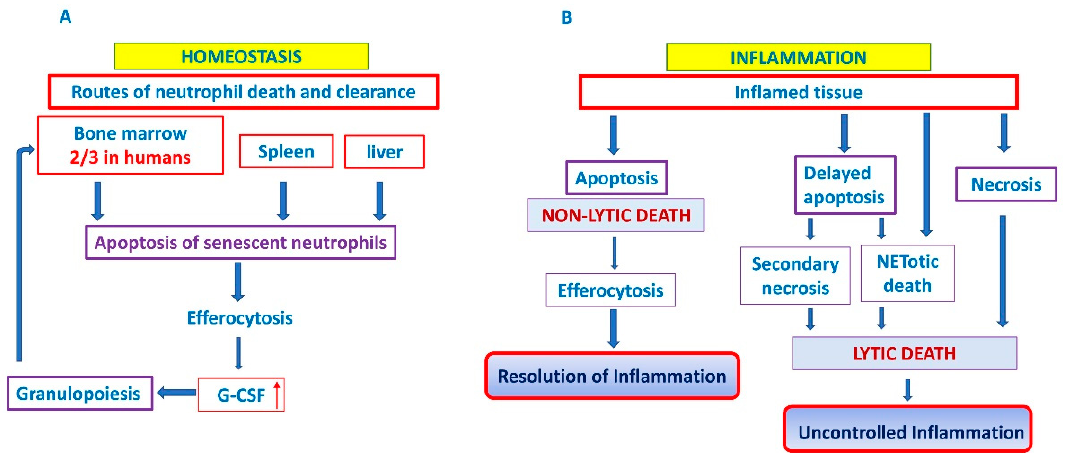
Figure 1. Neutrophil cell death and clearance. In homeostatic conditions, clearance of aged neu- trophils is believed to occur via their uptake into the bone marrow (predominantly in humans), liver and spleen. It generates homeostatic signals leading to granulocyte colony-stimulating factor (G-SCF) release that drives granulopoiesis as a positive feedback loop ( A ). In inflammatory conditions, two outcomes are possible: efferocytosis of apoptotic neutrophils and resolution of inflammation or delayed apoptosis and progression towards lytic cell death and uncontrolled inflammation ( B ). G-CSF: granylocyte colony stimulating factor. ↑ denotes increased expression.